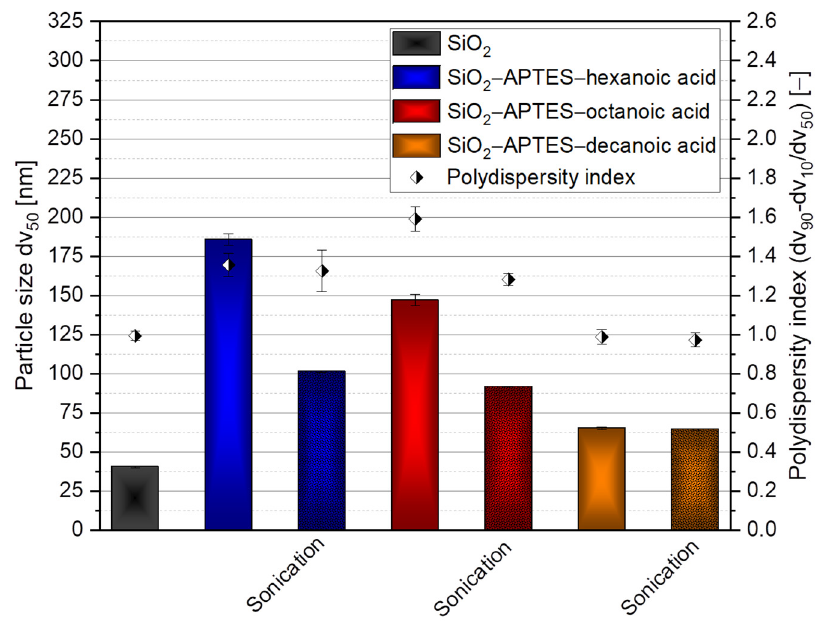
Figure 7. DLS measurements of unmodified silica as a reference (SiO 2 ) in ethanol, SiO 2 –APTES– hexanoic acid, SiO 2 –APTES–octanoic acid, and SiO 2 –APTES–decanoic acid in the solvent THF with and without